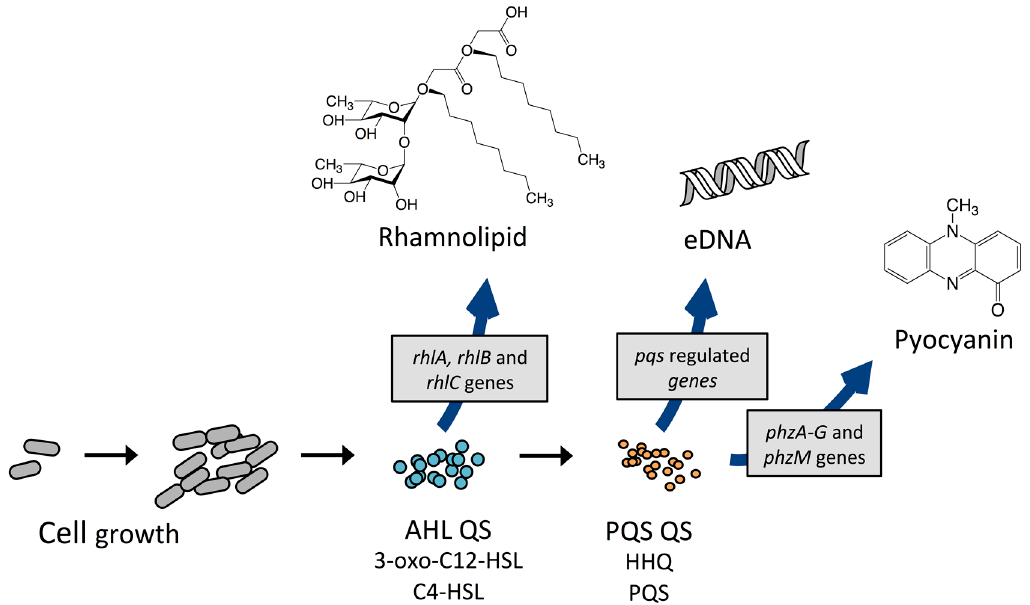
Figure 3. Production of QS regulated rhamnolipid, pyocyanin and eDNA by P. aeruginosa . QS: quorum sensing; AHL: N -acyl- L -homoserine lactone; 3-oxo-C12-HSL: N -(3-oxododecanyol)- L -homoserine lactone; C4-HSL: N -butanoylhomoserine lactone; HHQ: 2-heptyl-4-hydroxyquinoline; PQS (pseudomonas quinolone signal): 2-heptyl-3-hydroxy-4-guinolone.